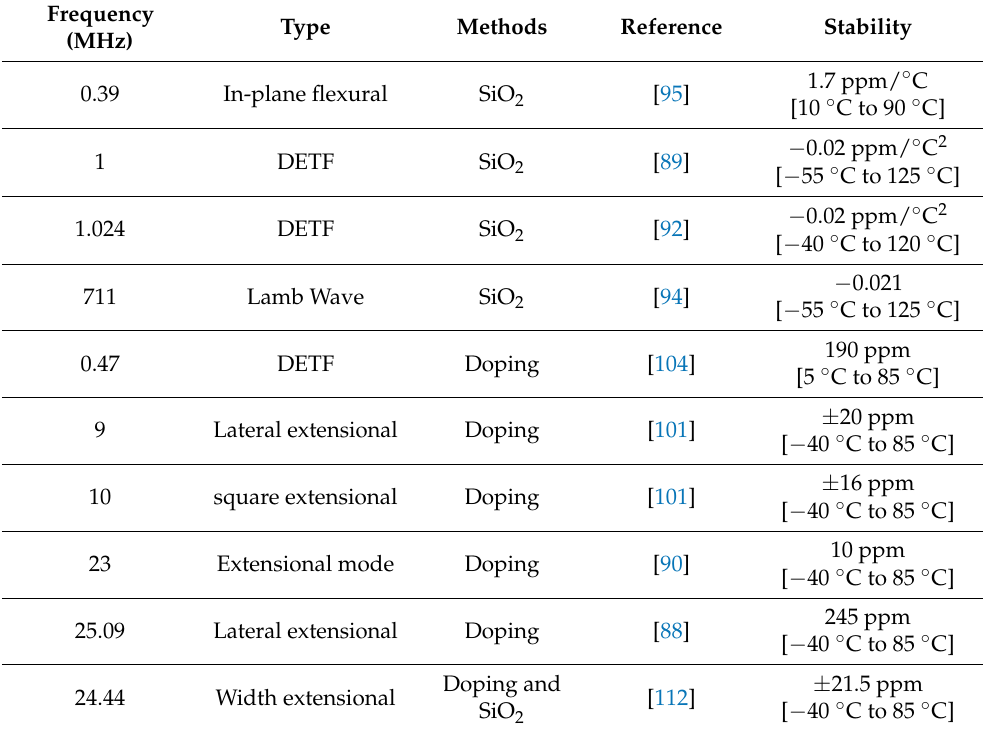
Table 4. Typical methods of passive